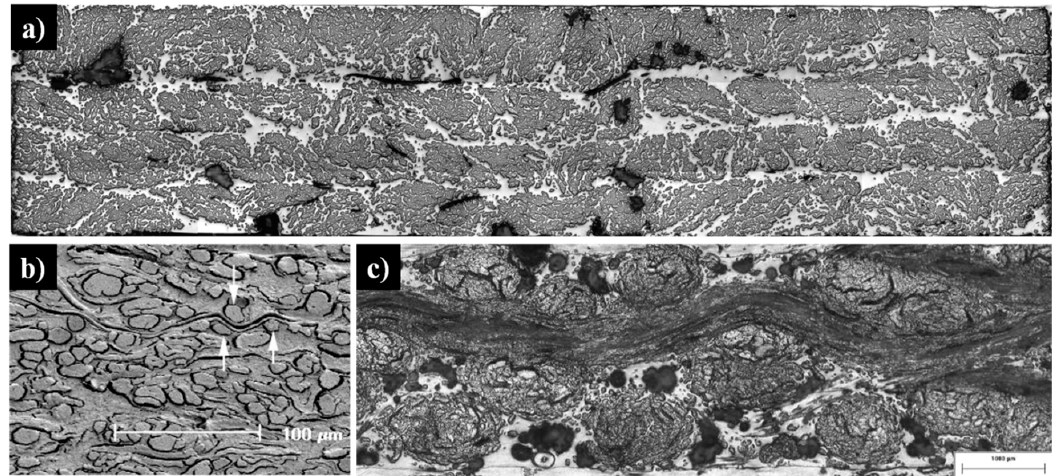
Figure 2. Compaction mechanisms in various plant fibre preforms: ( a ) yarn cross-section deformation, void consolidation, and nesting–packing in a non-woven unidirectional flax composite [14,41,42]. Image by the author DUS. ( b ) Fibre bending and flattening and void consolidation in a random mat wood fibre composite [40]; image reproduced with permission from © 2004 Wiley. ( c ) Yarn cross-section deformation and flattening and nesting–packing in a woven flax composite [43].